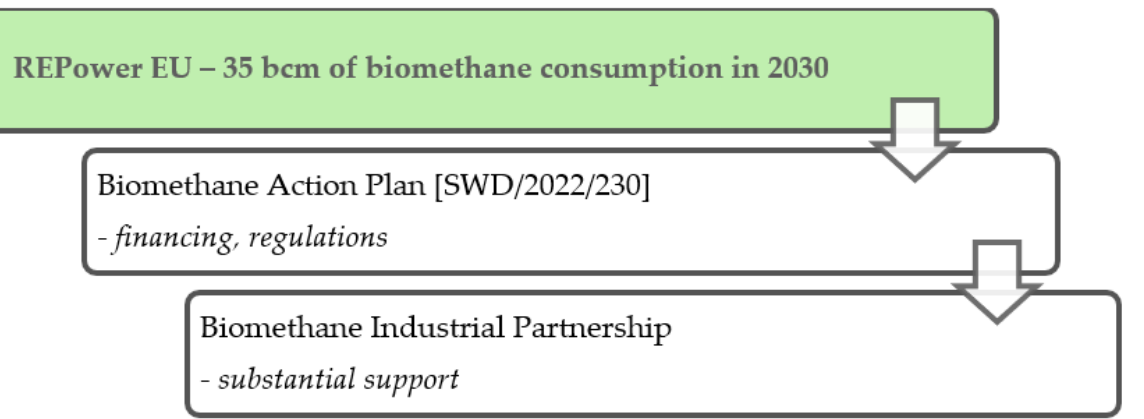
Figure 3. Scheme of REPower EU’s biomethane target realization. Source: own